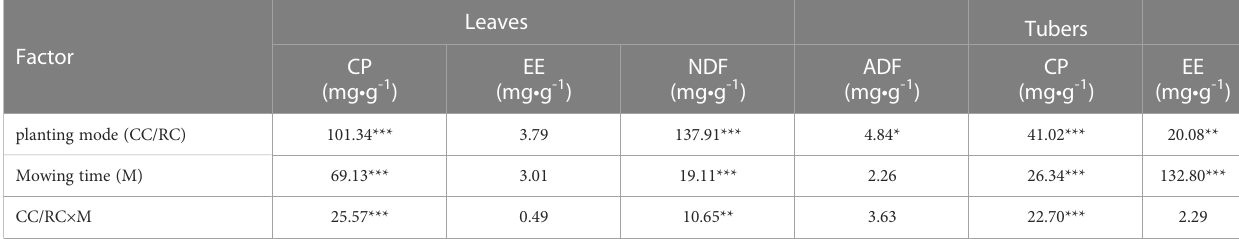
TABLE 6 Two-way ANOVA analysis of effects of the planting mode and mowing time on the forage nutritive value of the leaves of C. esculentus .